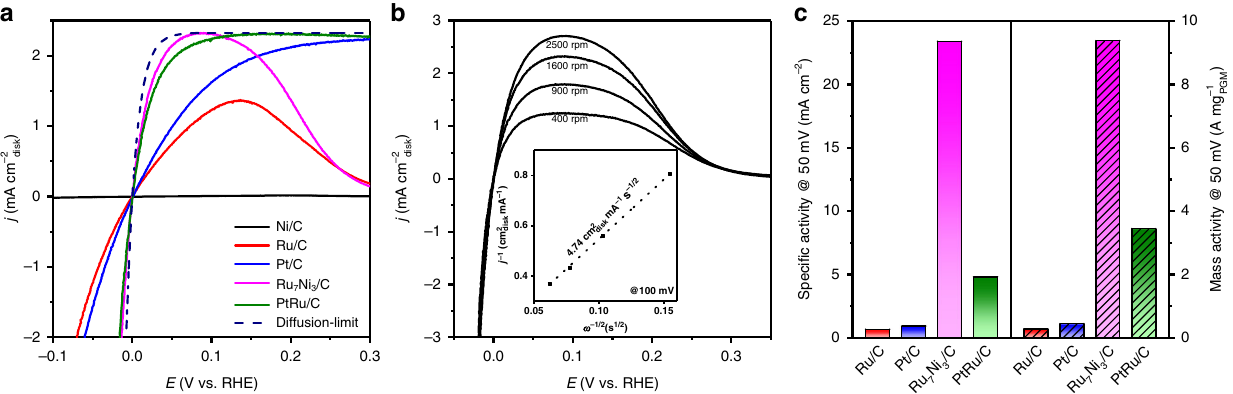
Fig. 2 Hydrogen oxidation reaction (HOR) activity tested by the RDE method. a HOR polarization curves of Ru/C, Ni/C, Pt/C, PtRu/C, and Ru 7 Ni 3 /C in H 2 -saturated 0.1 M KOH solution. Scan rate: 1 mV s − 1 ; rotation rate: 1600 rpm. All of the catalysts with a loading of 3.9 µ g PGM cm − 2 , except 3.9 µ g Ni cm − 2 for Ni/C. b Polarization curves of Ru 7 Ni 3 /C in H 2 -saturated 0.1 M KOH at a scan rate of 1 mV s − 1 at different rotation rates. Inset shows the Koutecky – Levich plot of Ru 7 Ni 3 /C at an overpotential of 100 mV. c Electrochemical surface area (ECSA) normalized speci fi c activity and precious metal (Ru or Pt)-based mass activity at 50 mV of the Ru/C, Pt/C, PtRu/C, and Ru 7 Ni 3 (Supplementary Fig. 4 and Supplementary Table 1). The kinetic ultrahigh activity of the Ru 7 Ni 3 /C and PtRu/C catalysts. We also current density of HOR was derived by the Koutecky – Levich normalized the activity to the precious metal loadings on the equation. Note that although ultra-low catalyst loadings were used electrode, and obtained the mass activity. The HOR speci fi c in the RDE experiments to move the polarization curves away from activities and mass activities at 50 mV of the catalysts are the diffusion overpotential curve, errors may still exist due to the summarized in Fig. 2c and Supplementary Table 1. The Ru 7 Ni 3 /C